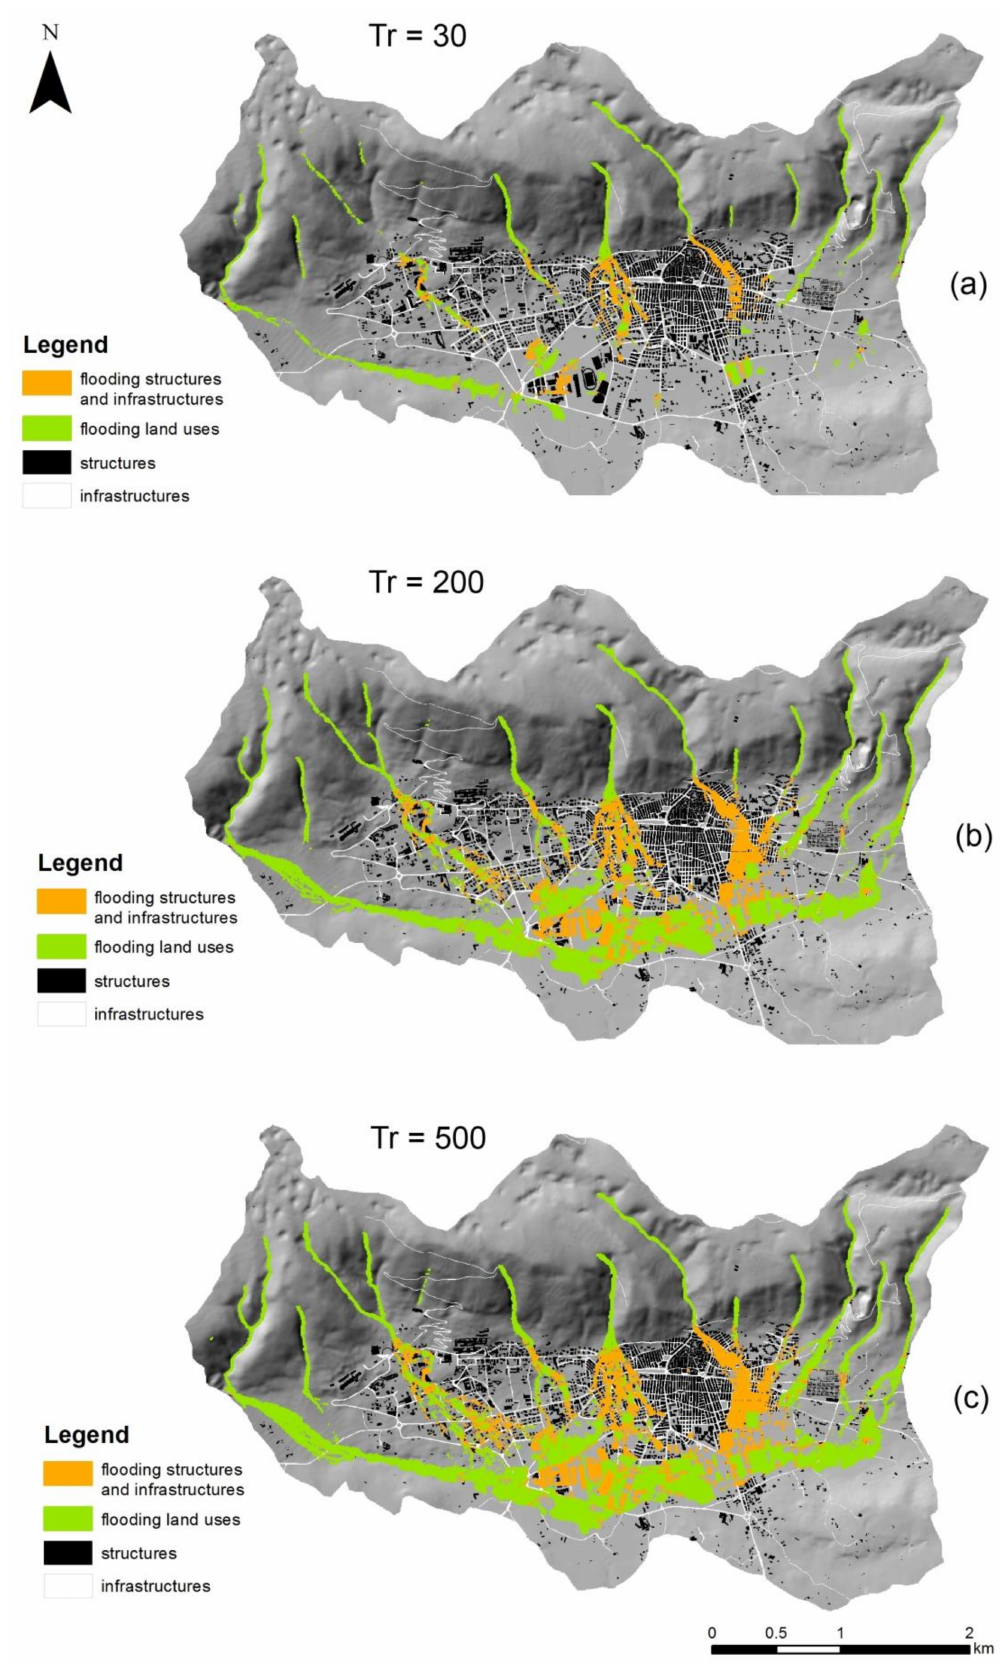
Figure 7. Elements at risk in flooding areas for the three hazard scenarios with return period of 30 ( a ), 200 ( b ) and 500 ( c )